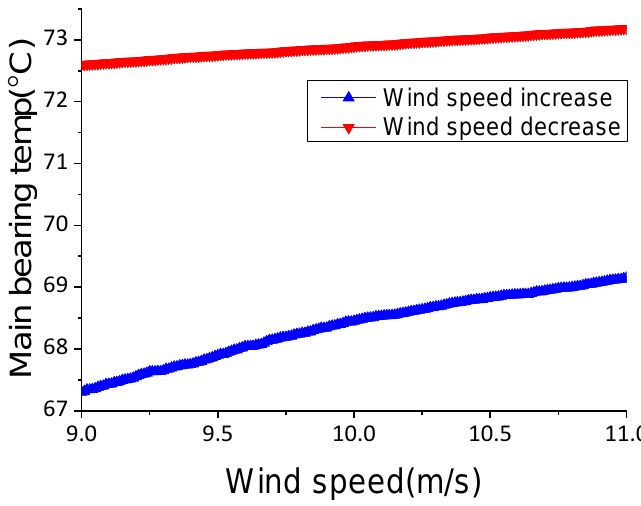
Figure 2. Main bearing temperature during wind speed increase and decrease.